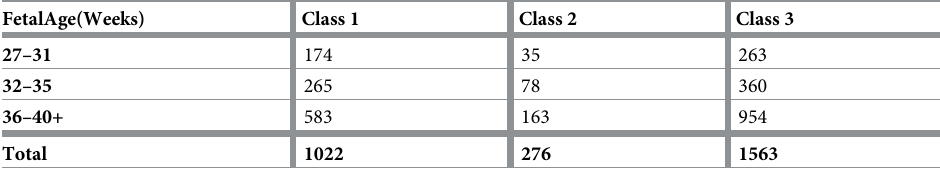
The total number of occurrences of each class can be observed. The fetal movement realizations are classified as Class 1, Maternal laugh realizations are classified as Class 2 and Maternal respiratory movement realizations are classified as Class